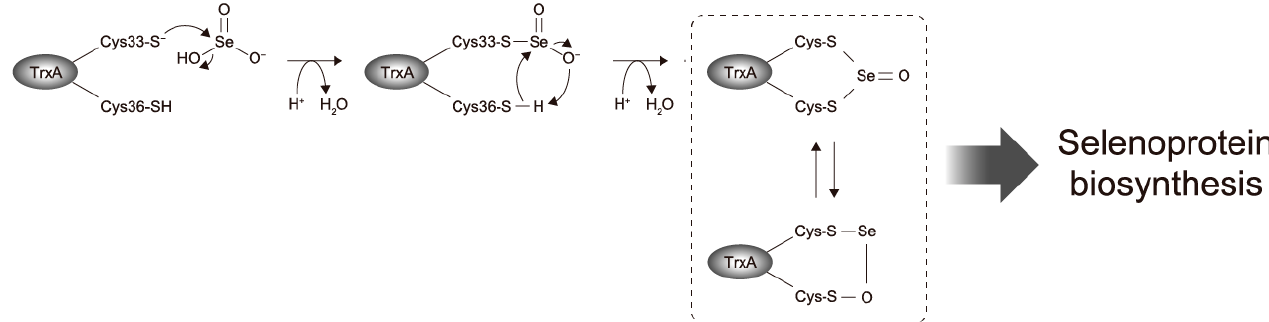
Figure 5. Proposed mechanism for early steps of selenite reduction via TrxA in the Trx system-dependent selenium delivery for selenoprotein biosynthesis.